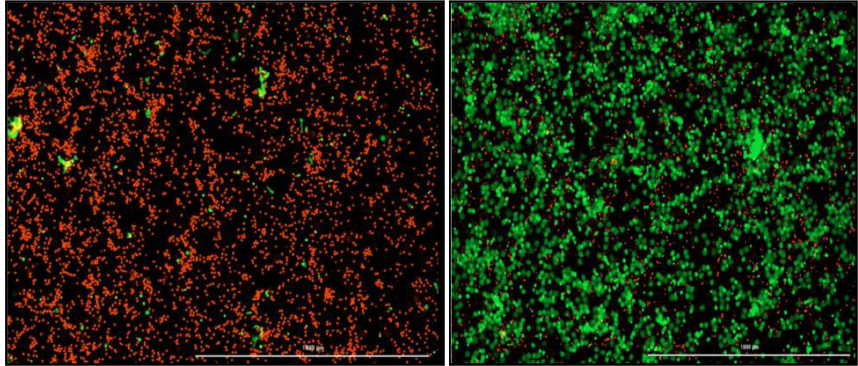
Figure 3. Images acquired with the Biotek Cytation 5 (1000 µM) to visualize and quantify NETosis. Red indicates intact neutrophils. Green indicates neutrophils undergoing NETosis and extruding their cellular DNA. (Left) Negative control which is only healthy neutrophils with no stimulation. (Right) Positive control, PMA stimulated